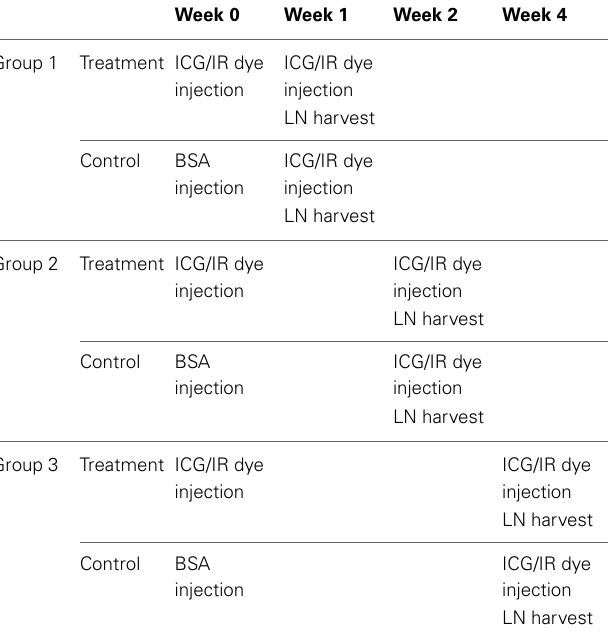
Table 1 | ICG time-course experimental